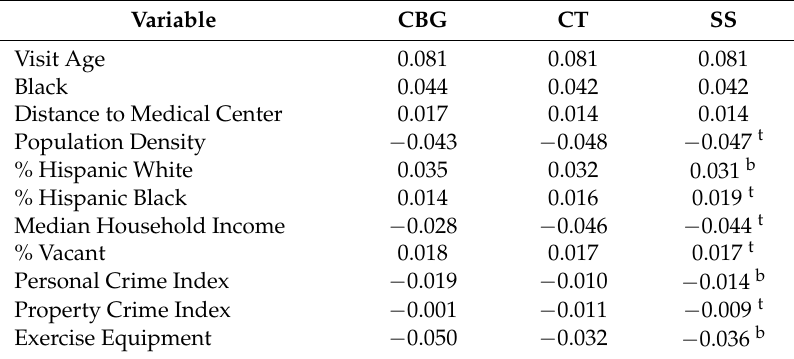
Table 6. OLS coefficient estimates for three models based on covariates that were selected by the spatial scale (SS) forward stagewise model of BMI z-score: (1) when constraining all selected area-level covariates to enter at the CBG level; (2) when constraining all selected area-level covariates to enter at the CT level; and (3) when allowing all selected area-level covariates to enter at the model-selected spatial scale. The horizontal dashed line separates the individual-level variables and the area-level variables. CBG